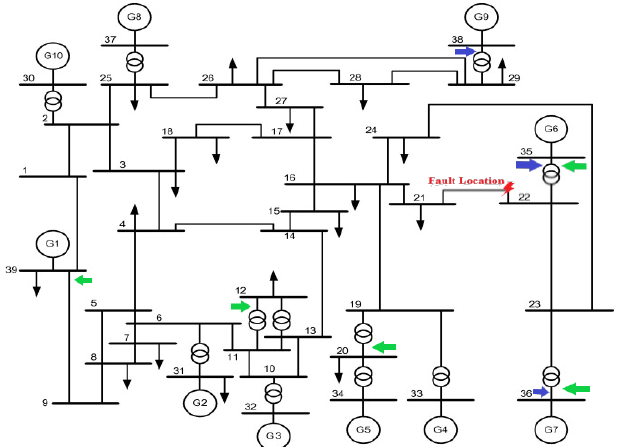
Figure 9. Locations of RSFCLs; blue ‐ colored arrows: Scenario 1; green ‐ colored arrows: Scenario 2.